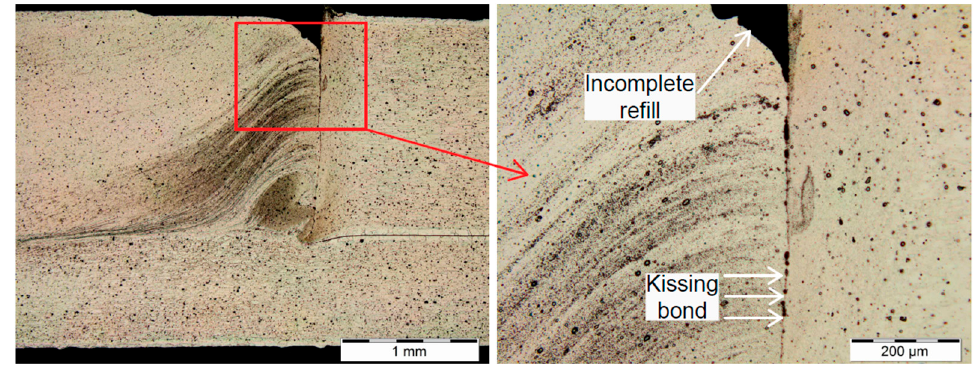
Figure 20. Defects in a weld fabricated with the following conditions: tool rotational speed n = 1800 rpm and duration of welding t = 1.5 s (experiment E4).